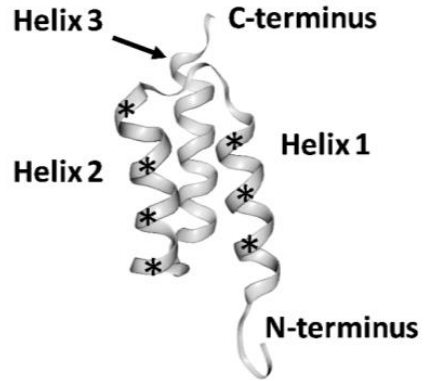
Figure 1. Structure of an affibody scaffold. Asterisks mark the segments where randomized amino acids are located. Image was obtained from the RCSB Protein Data Bank (rcsb.org) of PDB ID 2KZJ showing HER2-.